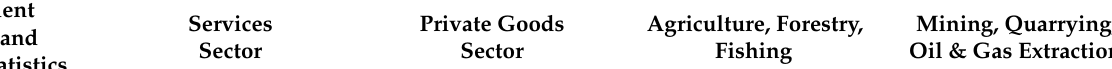
Table 7. Relationships between V.2 VNL masked average radiance and GDP by industry: counties, 2014–19. Independent